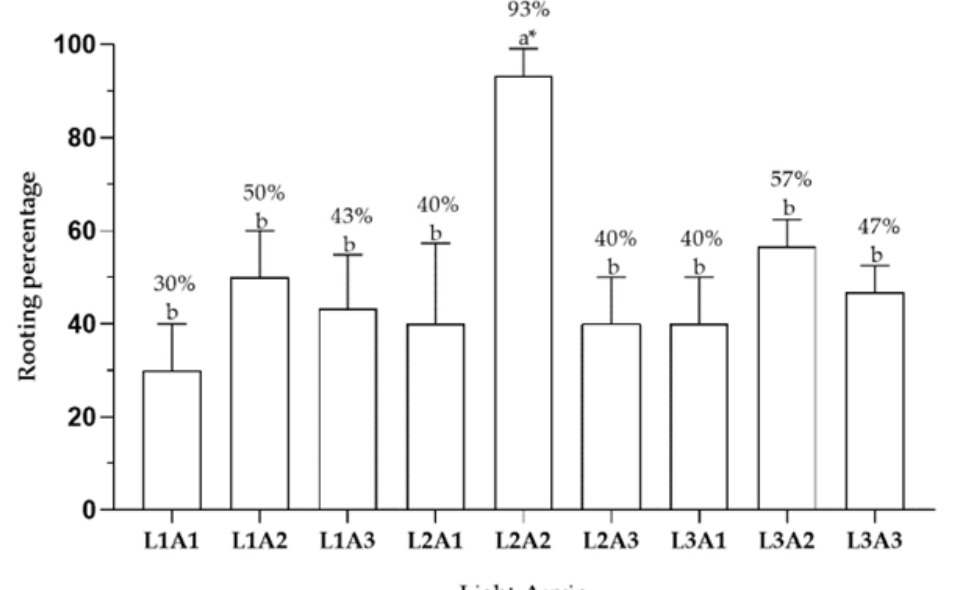
Figure 3. Effect of light type and IBA concentrations on rooting in C. mucronata vitroplants. L1A1: White light and 0 μM IBA; L1A2: White light and 14.76 μM IBA; L1A3: White light and 29.52 μM IBA; L2A1: Red:blue light 1:2 and 0 μM IBA; L2A2: Red:blue light 1:2 and 14.76 μM IBA; L2A3: Red:blue light 1:2 and 29.52 μM IBA; L3A1: Red:blue light 1:1 and 0 μM IBA; L3A2: Red:blue light 1:1 and 14.76 μM IBA; L3A3: Red:blue light 1:1 and 29.52 μM IBA. * Letters indicate significant differences according to Tukey’s test ( p ≤ 0.05). Bars represent the standard deviation.